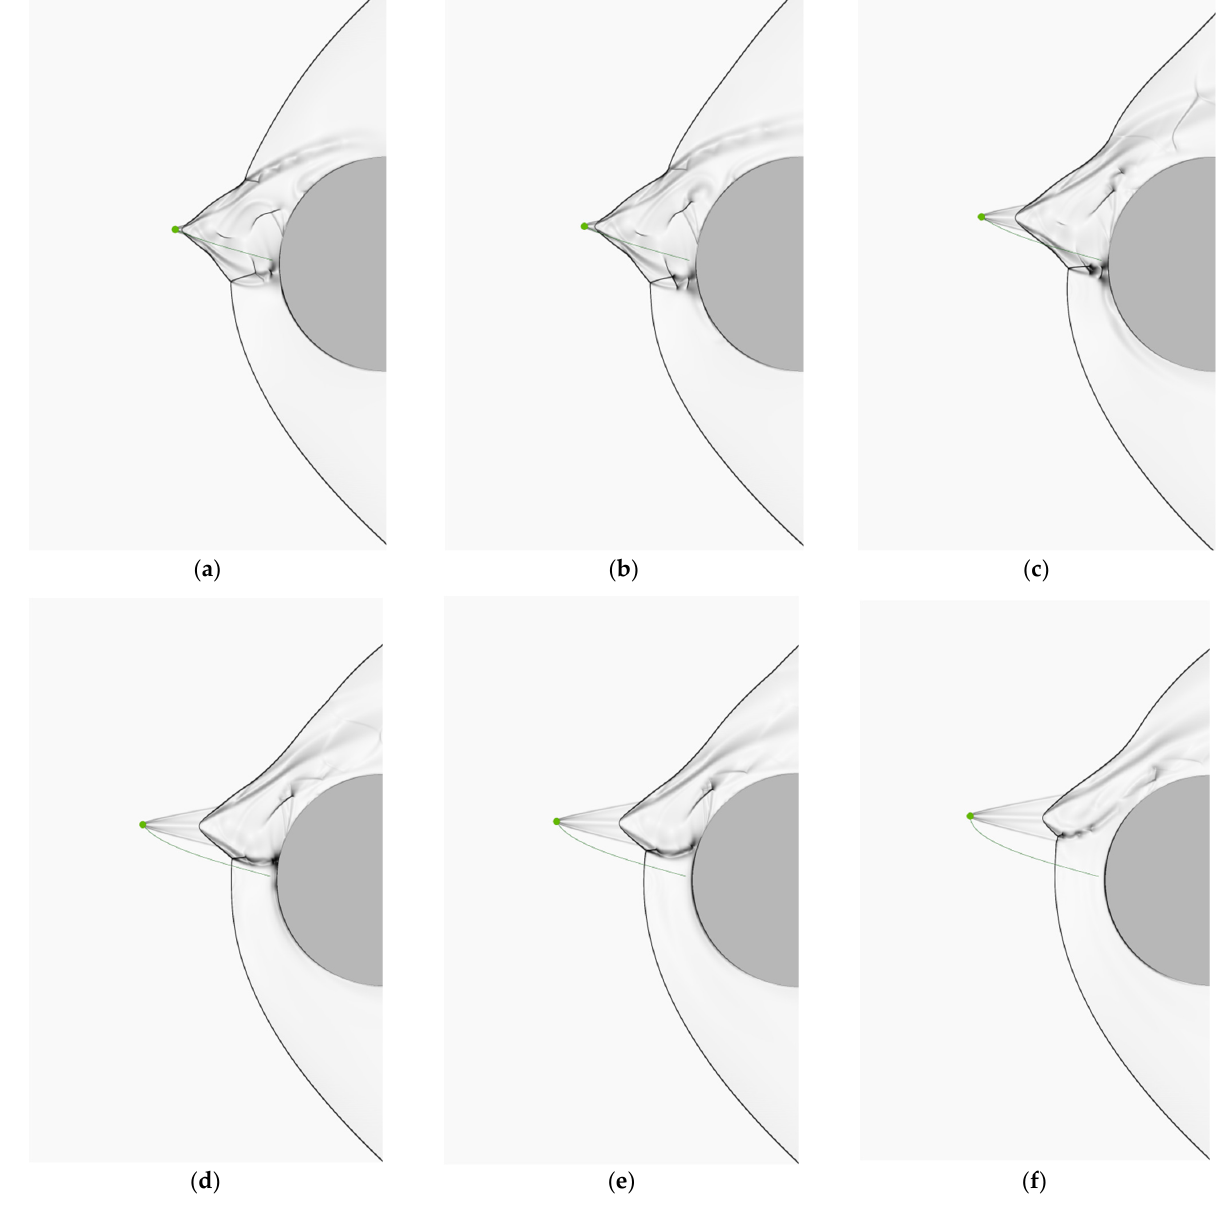
Figure 4. Schlieren images at different times. ( a ) —0.3 ms, ( b ) —0.34 ms, ( c ) —0.43 ms, ( d ) —0.53 ms, ( e ) —0.56 ms, ( f ) —0.63 ms.